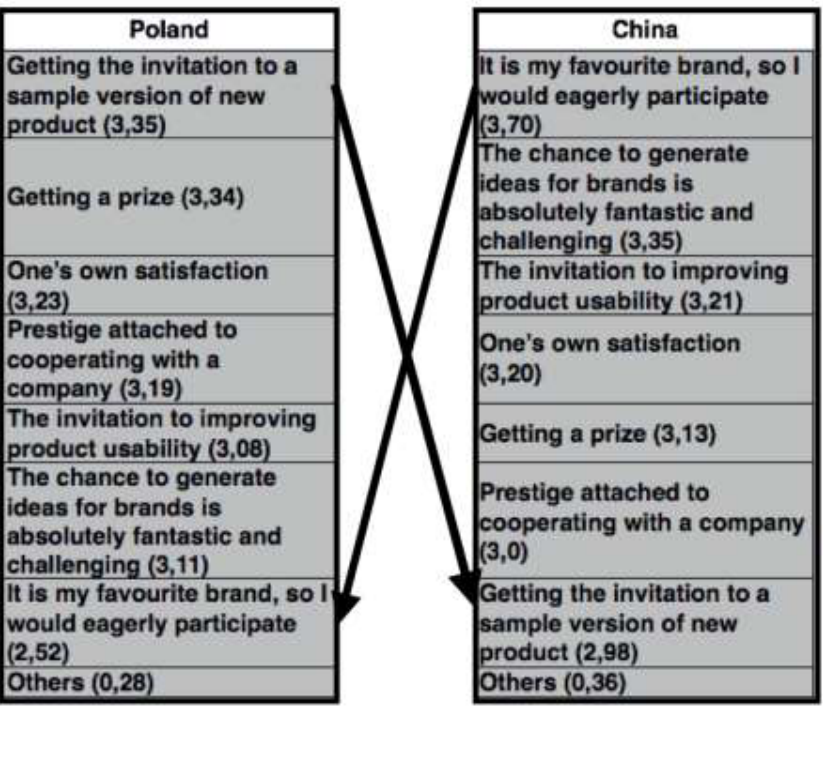
Fig. 1: Average rank assigned to reasons that would encourage young people to participate in the co-creation process by the surveyed young people in Poland and in China Source: own collaboration based on the survey